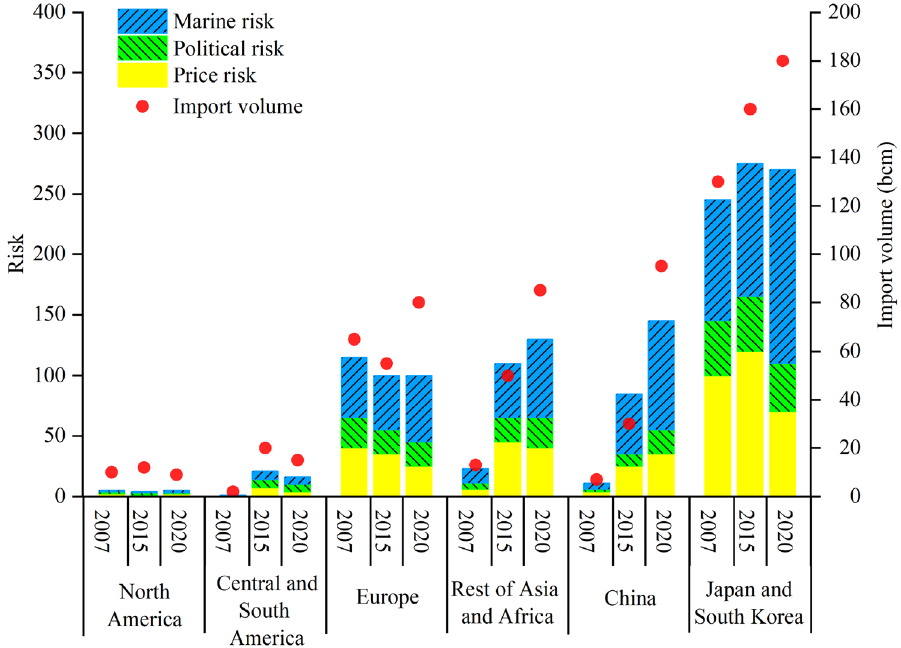
Figure 2. The comparison of LNG import risks in different import markets in different